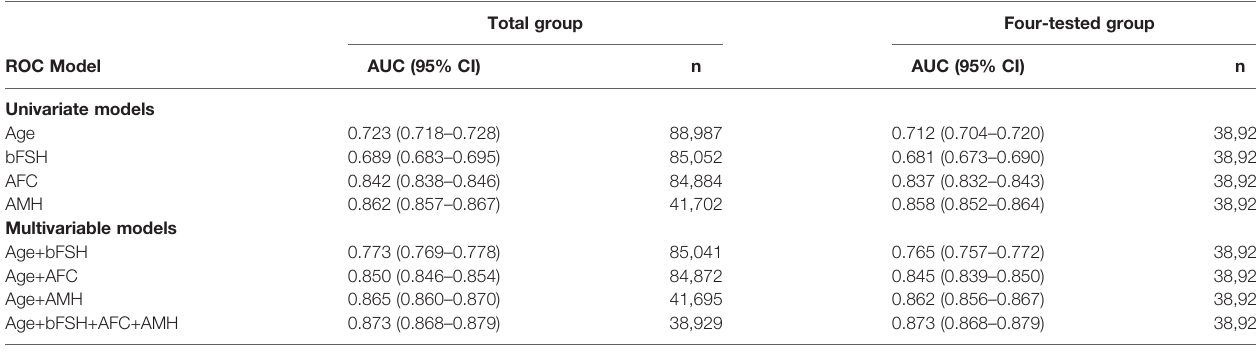
TABLE 3 | AUCs of prediction models of age and ORTs for the prediction of POR.